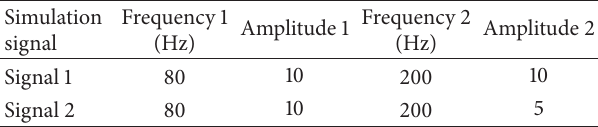
Table 1: Components of two simulation signals.